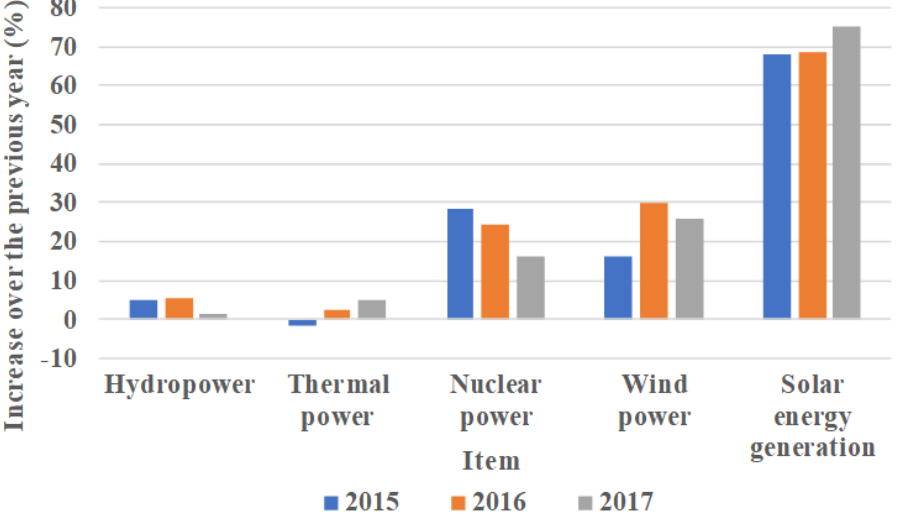
Figure 10. Power generation growth rate in China